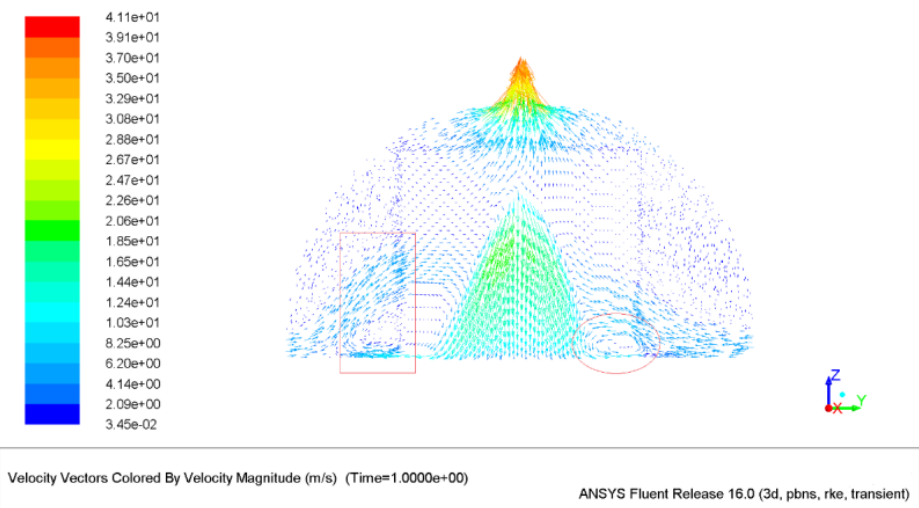
Figure 15. Display of the speed vector on the sprayed sector. It can be seen that the velocity swirl on the y -axis positive side of the spraying fan